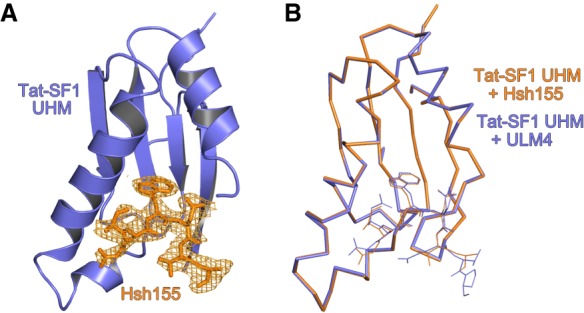
Overall structure of the Hsh155 ULM bound to the Tat-SF1 UHM at 2.0 Å resolution. (A) Feature-enhanced electron density map (Afonine et al. 2015) (1.5 σ contour level) of Hsh155 ULM (orange) bound to Tat-SF1 UHM (blue). (B) Superposed Cα-backbone traces of Hsh155-bound compared to ULM4-bound Tat-SF1 UHM structures.